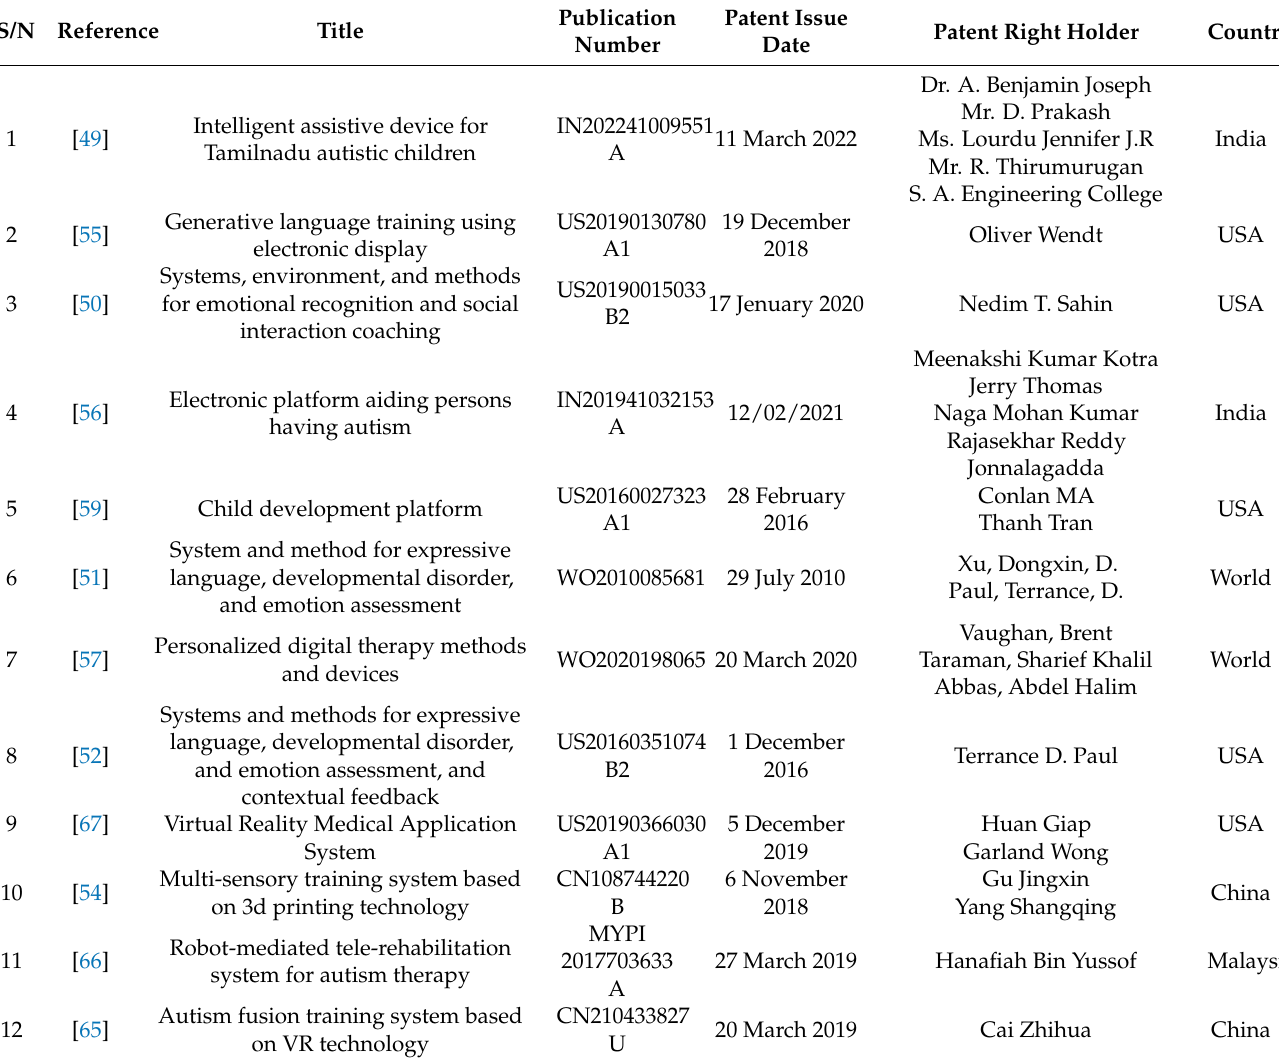
Table 10. Sample of assistive technology patents in the form of virtual